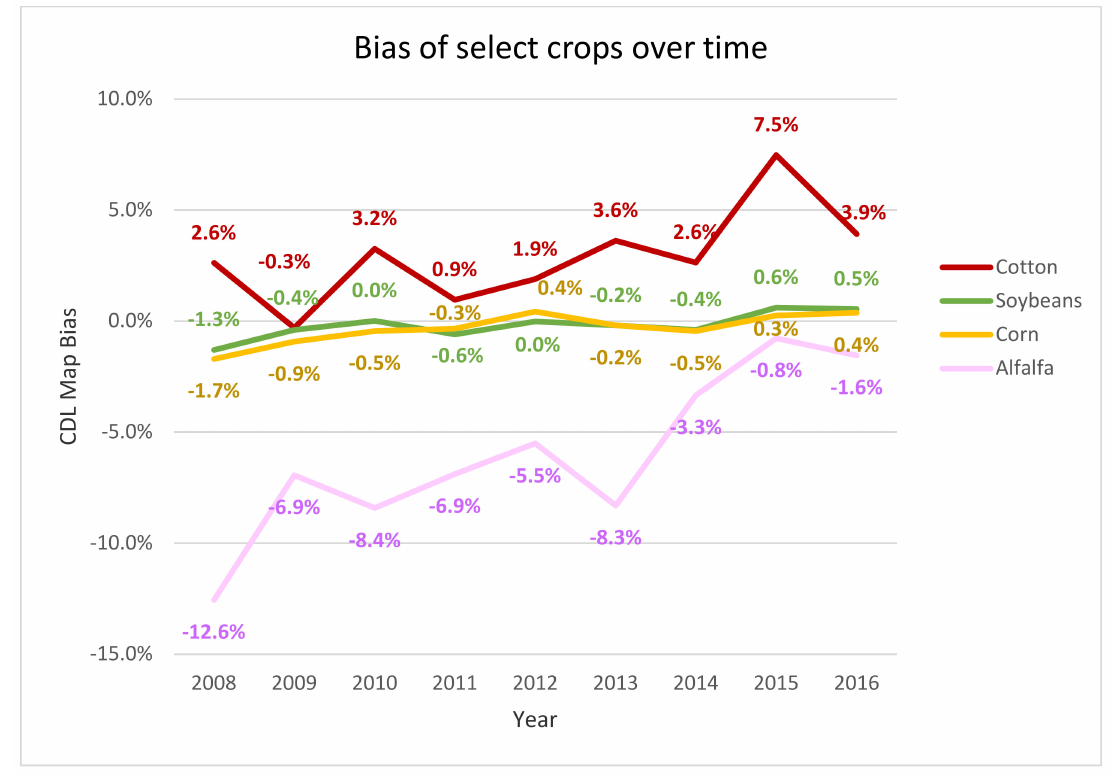
Figure 4. Mapping bias of select crops over time. The biases represent the relative over-representation (positive values) or under-representation (negative values) of crops by the CDL in each year according to comparison with the products’ reference